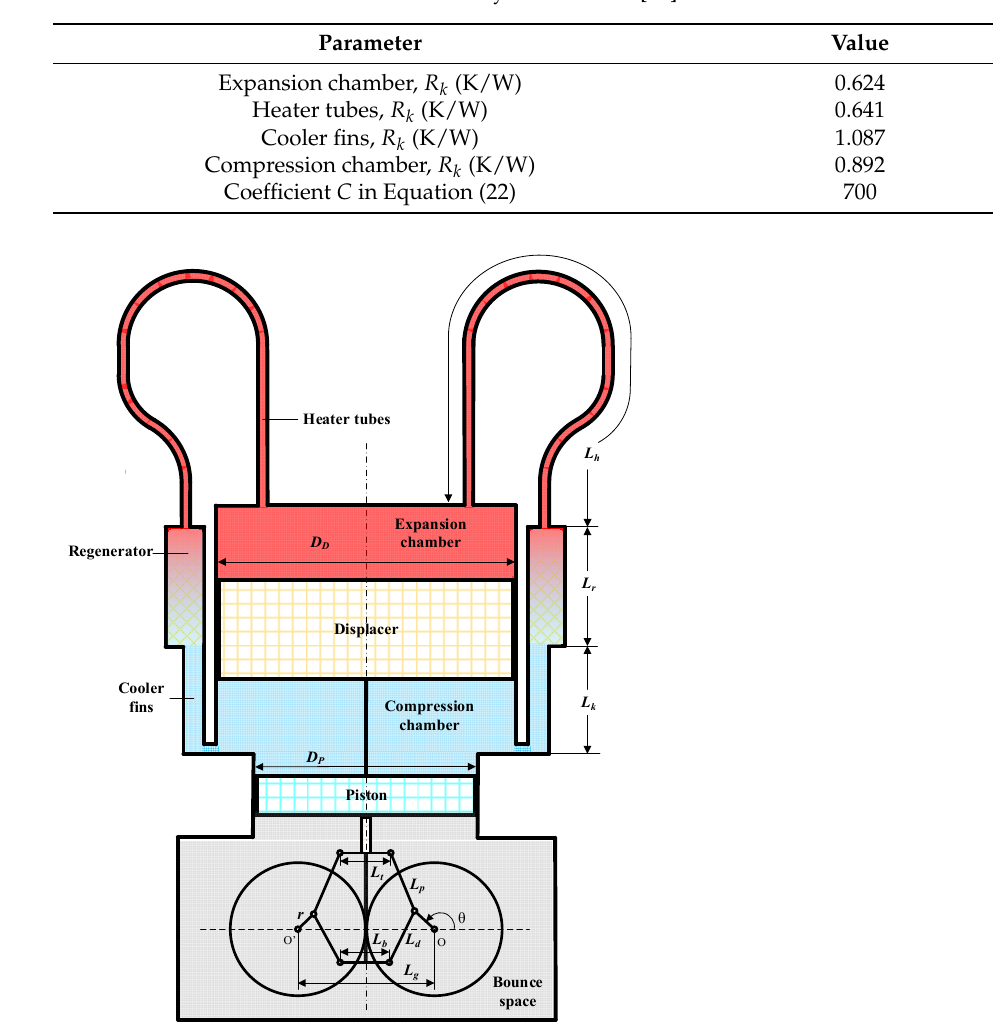
Table 3. Values of unknowns in the thermodynamic model [17].